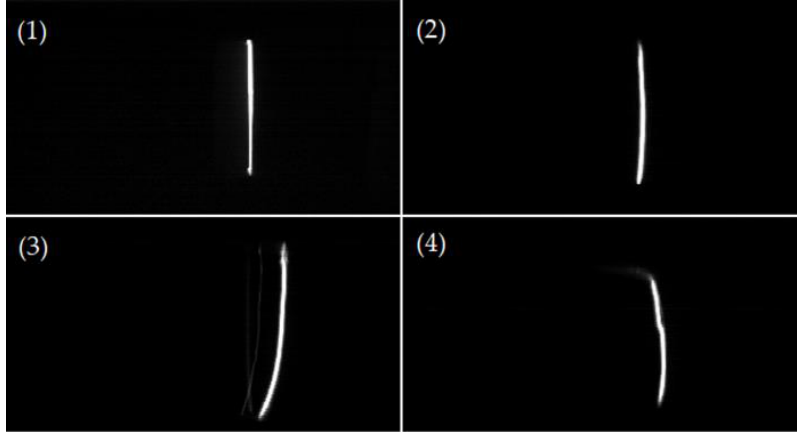
Figure 14. Four kinds of flashover paths.